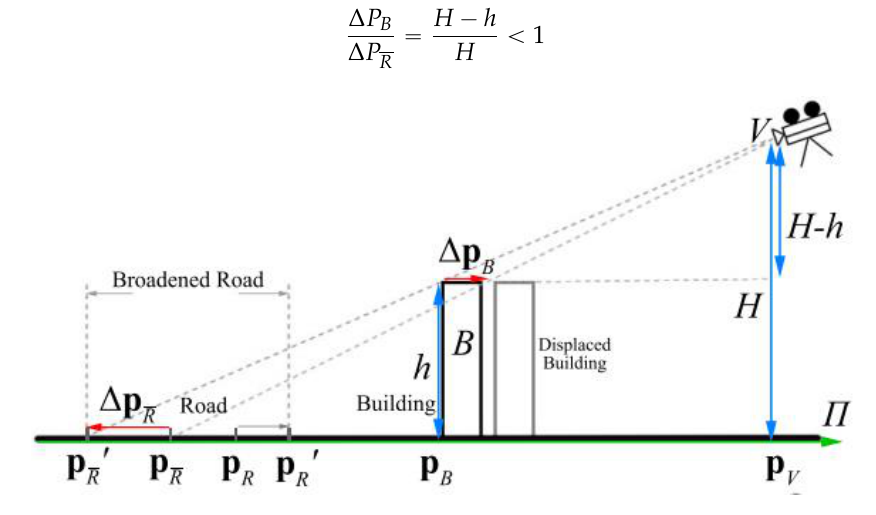
Figure 3. Disocclusion operators .